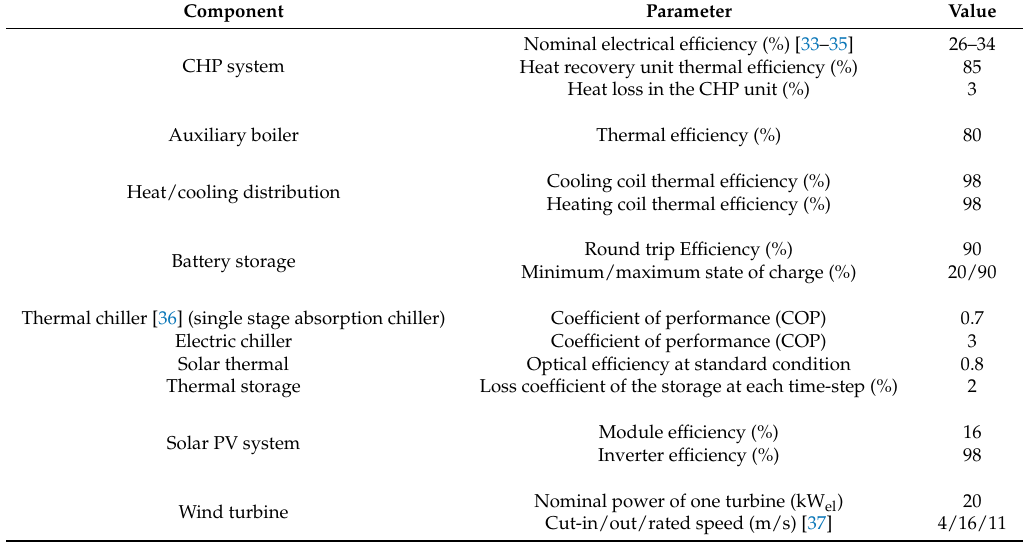
Table 2. Technical specification of each component.